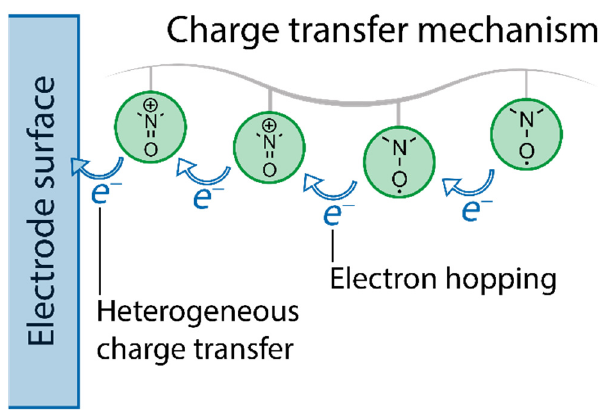
Figure 4. Schematic illustration of the redox reaction in TEMPO-containing polymer between nitroxide radical and oxoammonium cation.